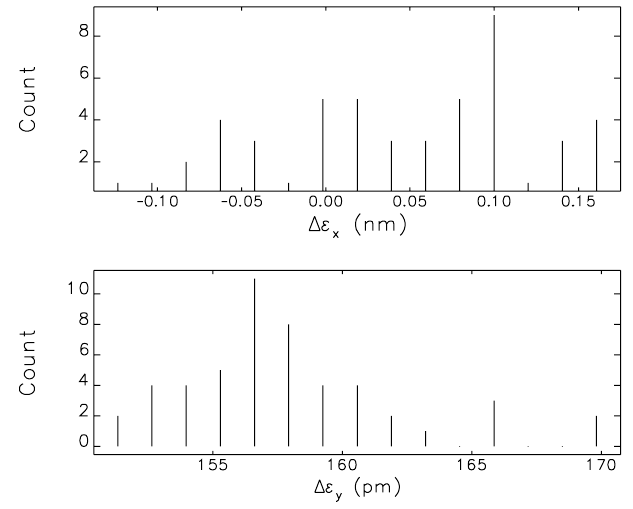
FIG. 18. Histograms of the increase in the eventual horizontal and vertical emittances for h (cid:3) 8 and V (cid:3) 4 MV with 0.25 mrad rms rolls of quadrupoles and sextupoles between the crab